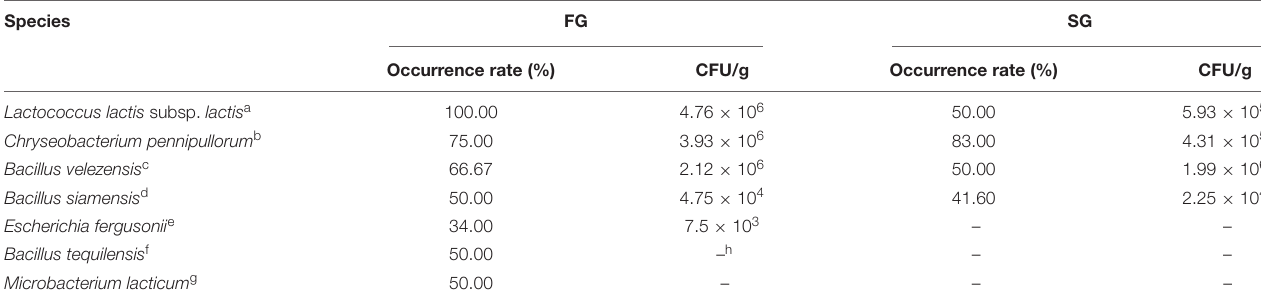
TABLE 1 | Species with a higher occurrence rate or number in plates of fast-growing (FG) group compared with those of slow-growing (SG) group. Species